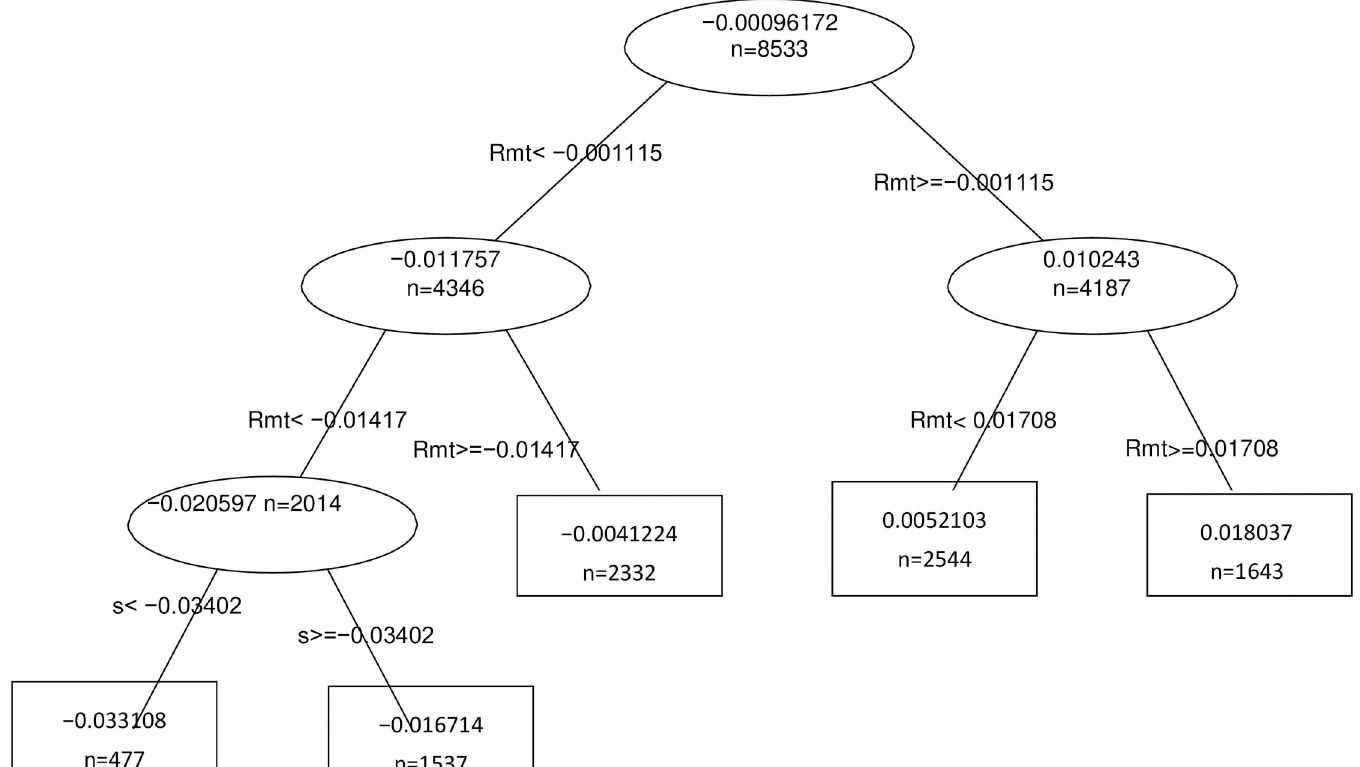
Fig 3. Decision Tree Reform 2012. R it = α i + β 1i Rmt+ β 2i PR+ β 3i PC+ β 4i TED + S β k Industry i + + λ Eventwindow i + ξ Agreement i+ ε it where R it is the return on company i on day t , R mt is the return on the market on day t (IBEX35) , PR Risk Premium , PC Slope of the Sovereign Yield Curve , TED Ted Spread , Industry is a dummy variable per industry , Eventwindow is a dummy variable that has the value 1 for the 11 days of the study window , and dummy Agreement , that takes the value 1 if the company has firm level agreement and 0 if it has a sectorial agreement